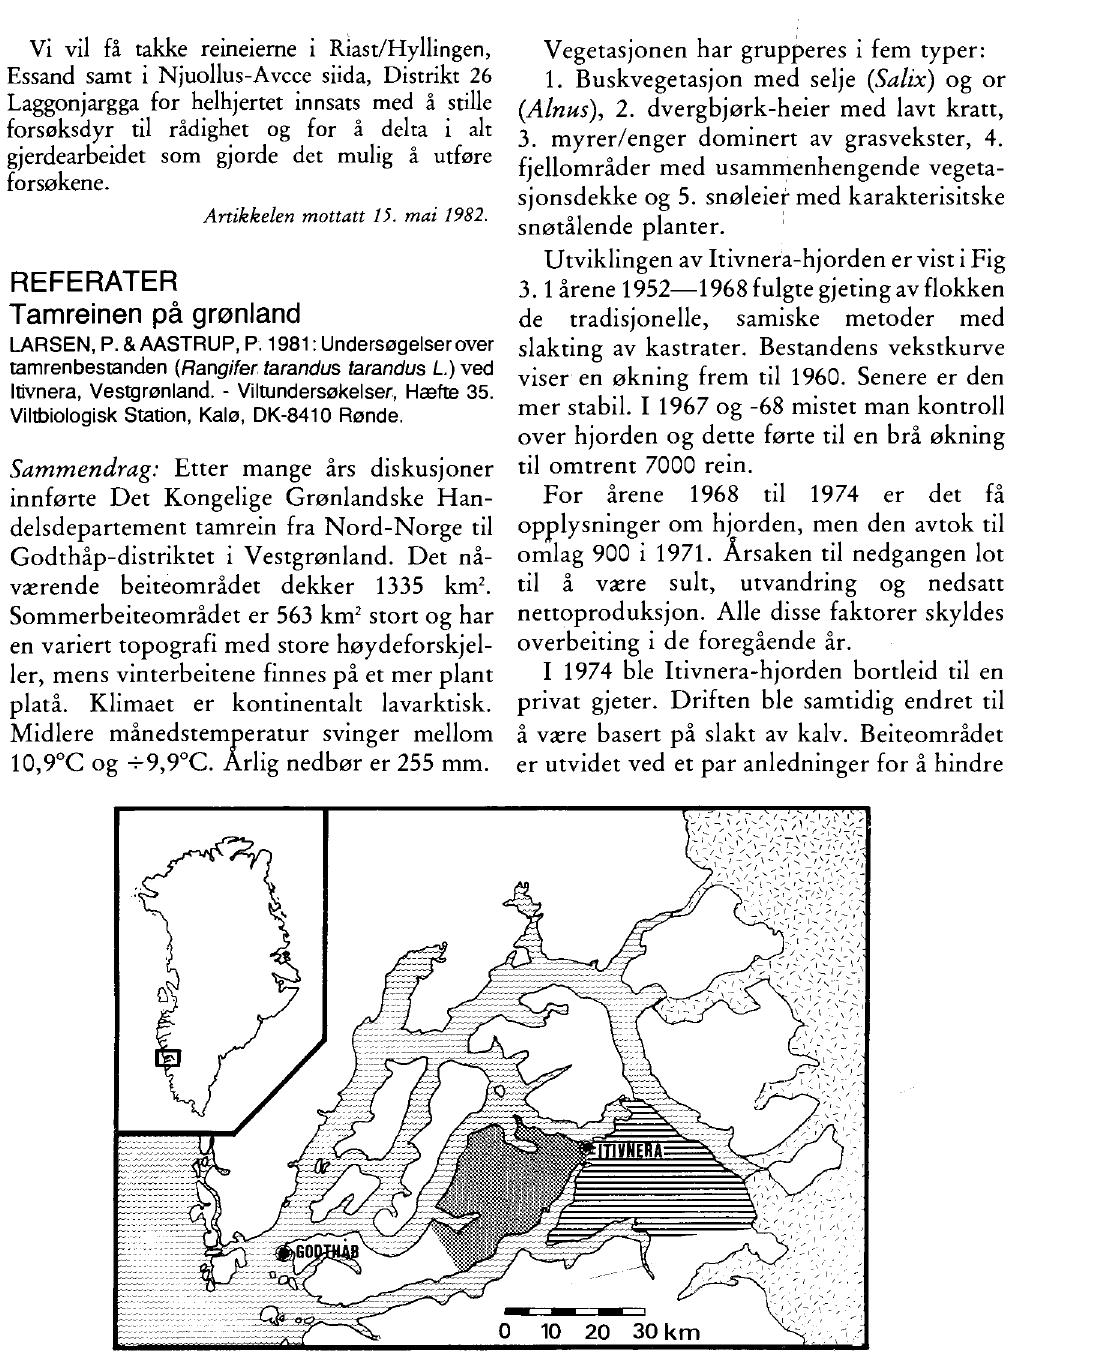
Fig. 1. Itivnera-renavlsområdet ved Godthåbsfjorden i Grønland. Prikket areal: sommerområde, skraveret areal: vinterområde. Flg. 1. The Itivnera reindeer range in the Godthåbs-fiord region, Greenland. Dotted area: summer range, hatched area: winter